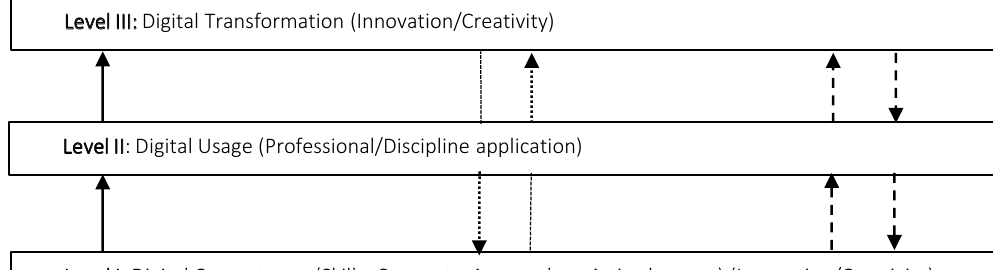
Figure 2. Three levels of digital literacy